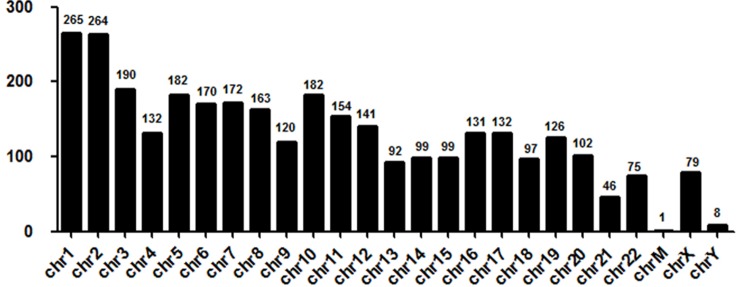
Chromosome distribution of long noncoding RNAs (lncRNAs) differentially expressed in plasma between the DCM and ICM patients. chr, chromosome; M, mitochondrial.